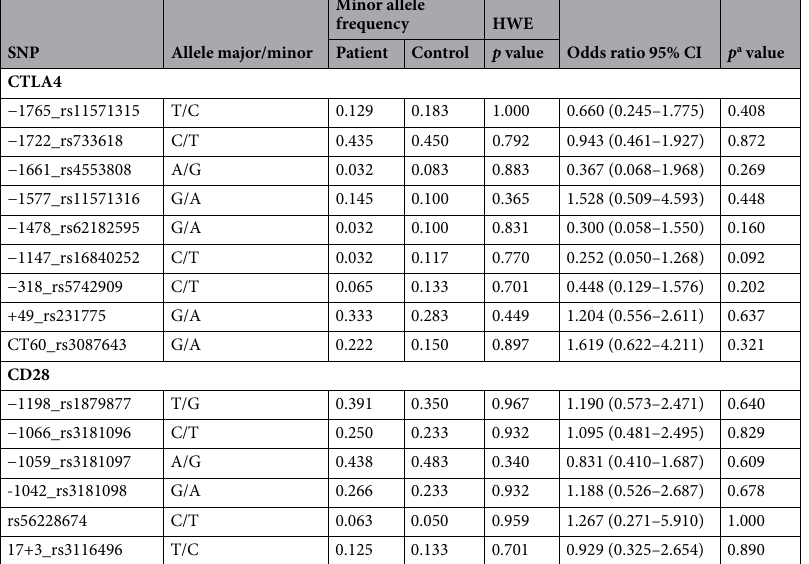
Table 2. Statistical analysis of CTLA4 and CD28 allele frequency. HWE Hardy–Weinberg equilibrium, 95% CI 95% confidence interval; p a values were counted from Chi-square test or Fisher’s exact